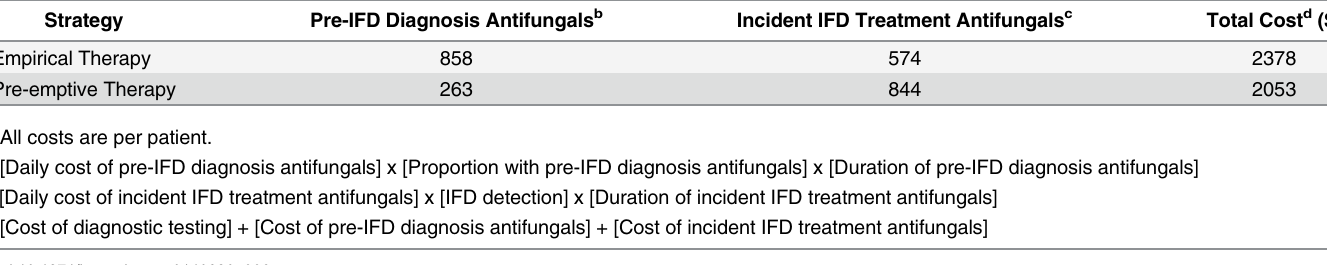
Table 6. Results of the cost-comparison model a